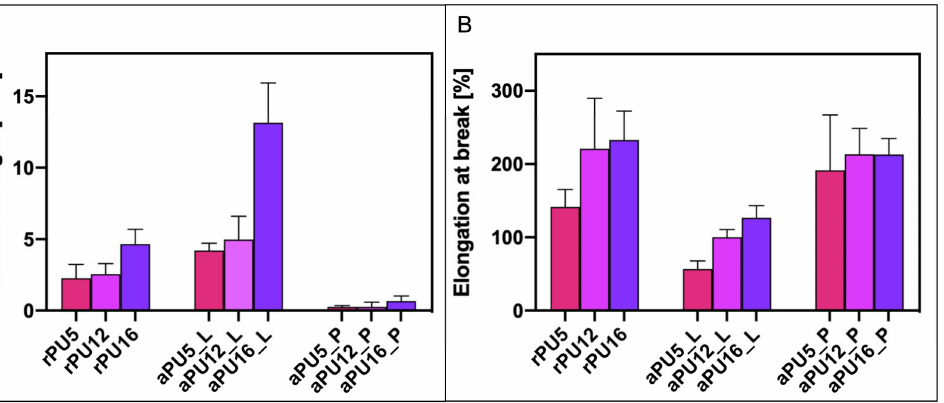
Figure 6. Comparison of ( A ) tensile strength and ( B ) strain at break values for investigated